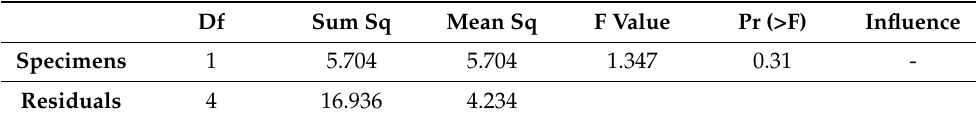
Table 5. ANOVA of mass loss of TF-R, U-R specimens at 780 s. Df Sum Sq Mean